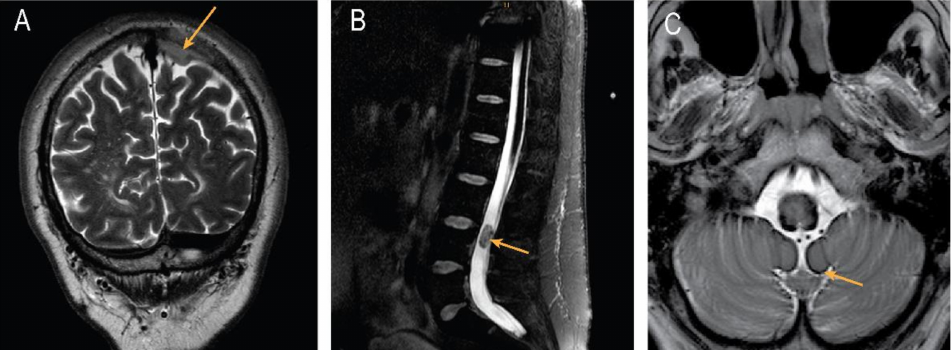
Figure 1. Brain and spinal magnetic resonance imaging (MRI). ( A ) Coronal T2-weighted imaging showing left parietal meningioma; ( B ) sagittal T2-weighted imaging using Spectral Attenuated Inversion Recovery (SPAIR) of a myxopapillary ependymoma near the conus terminalis (L3/4); ( C ) T2-weighted images of cerebellum and brainstem showing superficial